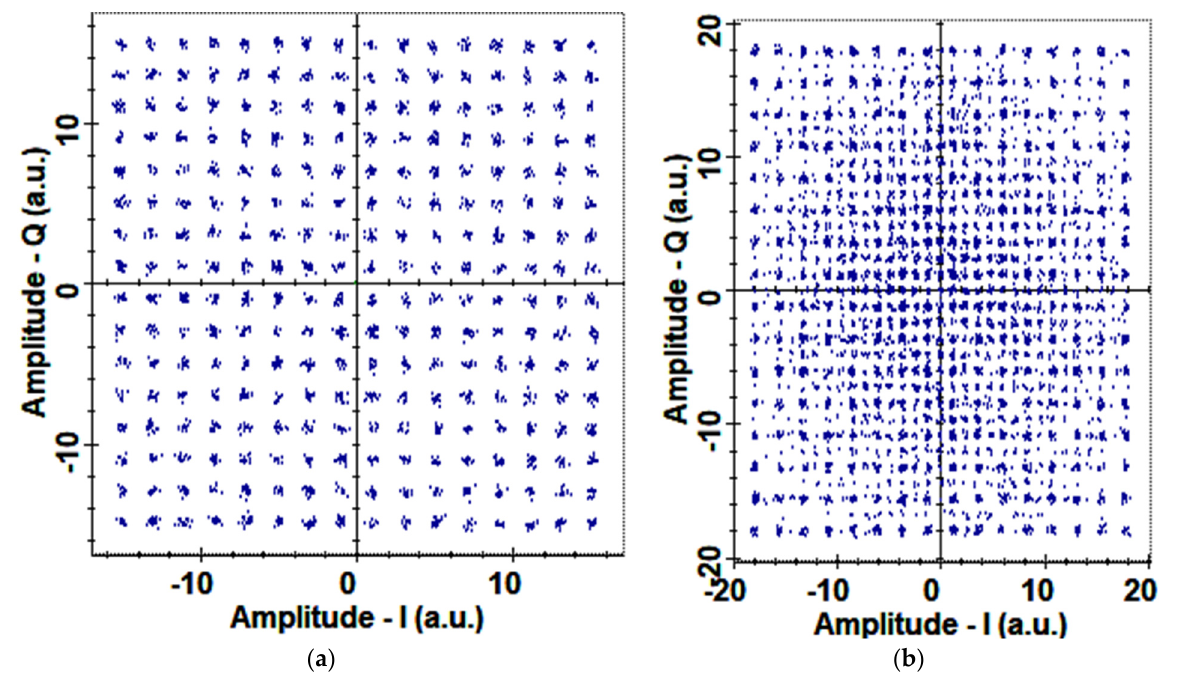
Figure 12. A 2D plot of 256 ‐ QAM symbols on the I and Q axis at OSC link length of ( a ) 22,000 and ( b ) 24,000 km.